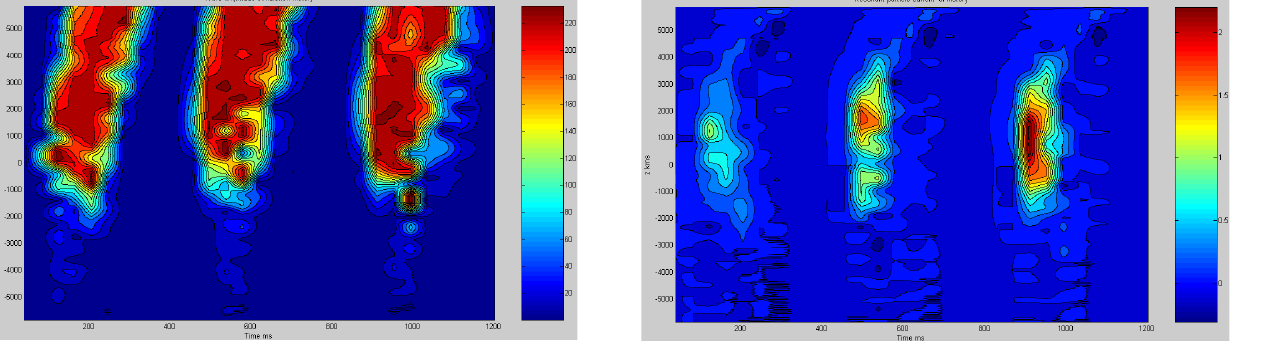
Fig. 10. Wave amplitude history (in pT) of the simulation as a con- Fig. 12. Fig. 12. For Ne=5 electrons/cc, the history of the out-of-phase cur- Fig. 10. tour plot in the z,t plane, for the case of Ne=5 electrons/cc. The rent J i as a contour plot in the z,t plane for the whole simulation stable character of the GR is again evident. As power input falls run. Note the large peak in J i of maximum value 2, giving a positive with rising frequency, the structure slips downstream, away from value to d/dz(J i /E ) and hence positive frequency sweep rate. the geomagnetic equator at z =0, at the group velocity which is in the upward direction.